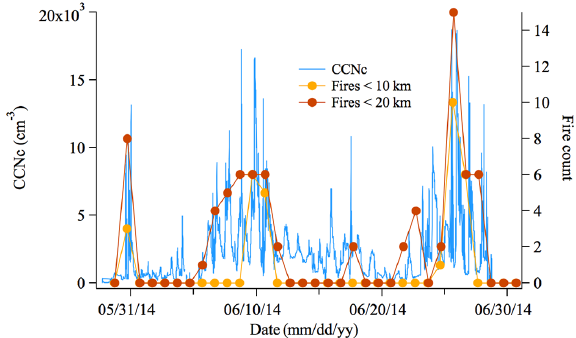
Figure 2. The time series of total cloud condensation nuclei con- centrations (CCNc) at 0.5% supersaturation and the total number of satellite-observed fires within 10km (yellow) and 20km (red) of the sampling